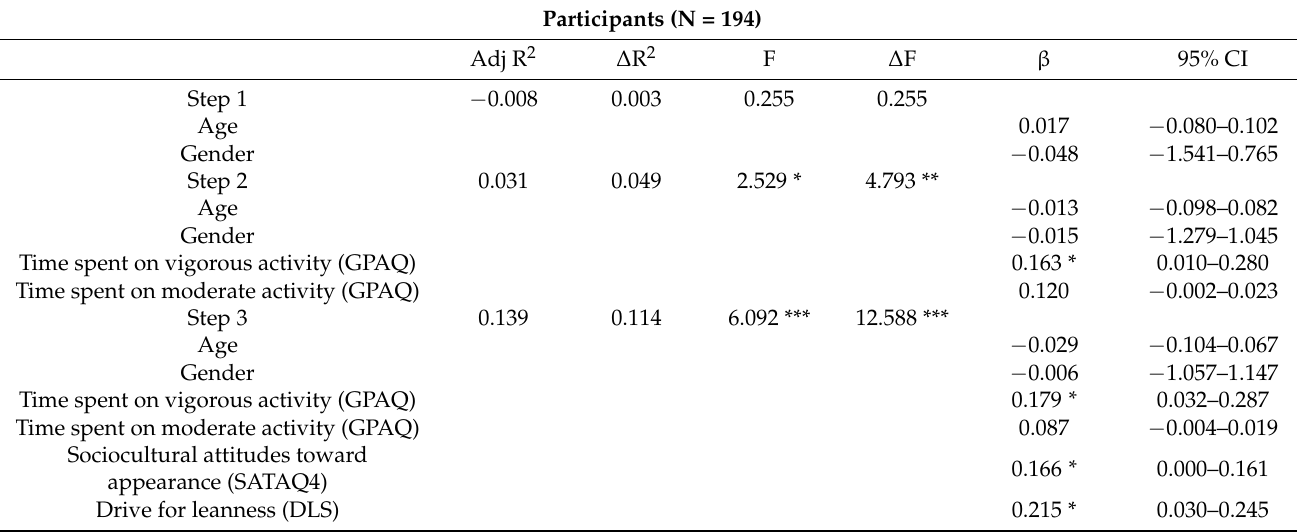
Table 3. Hierarchical regression